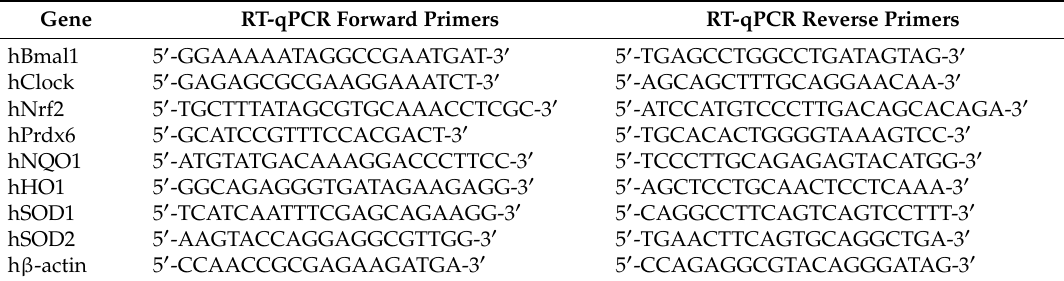
Table 1. Human RT-qPCR primers and sequences (5 (cid:48) to 3 (cid:48)